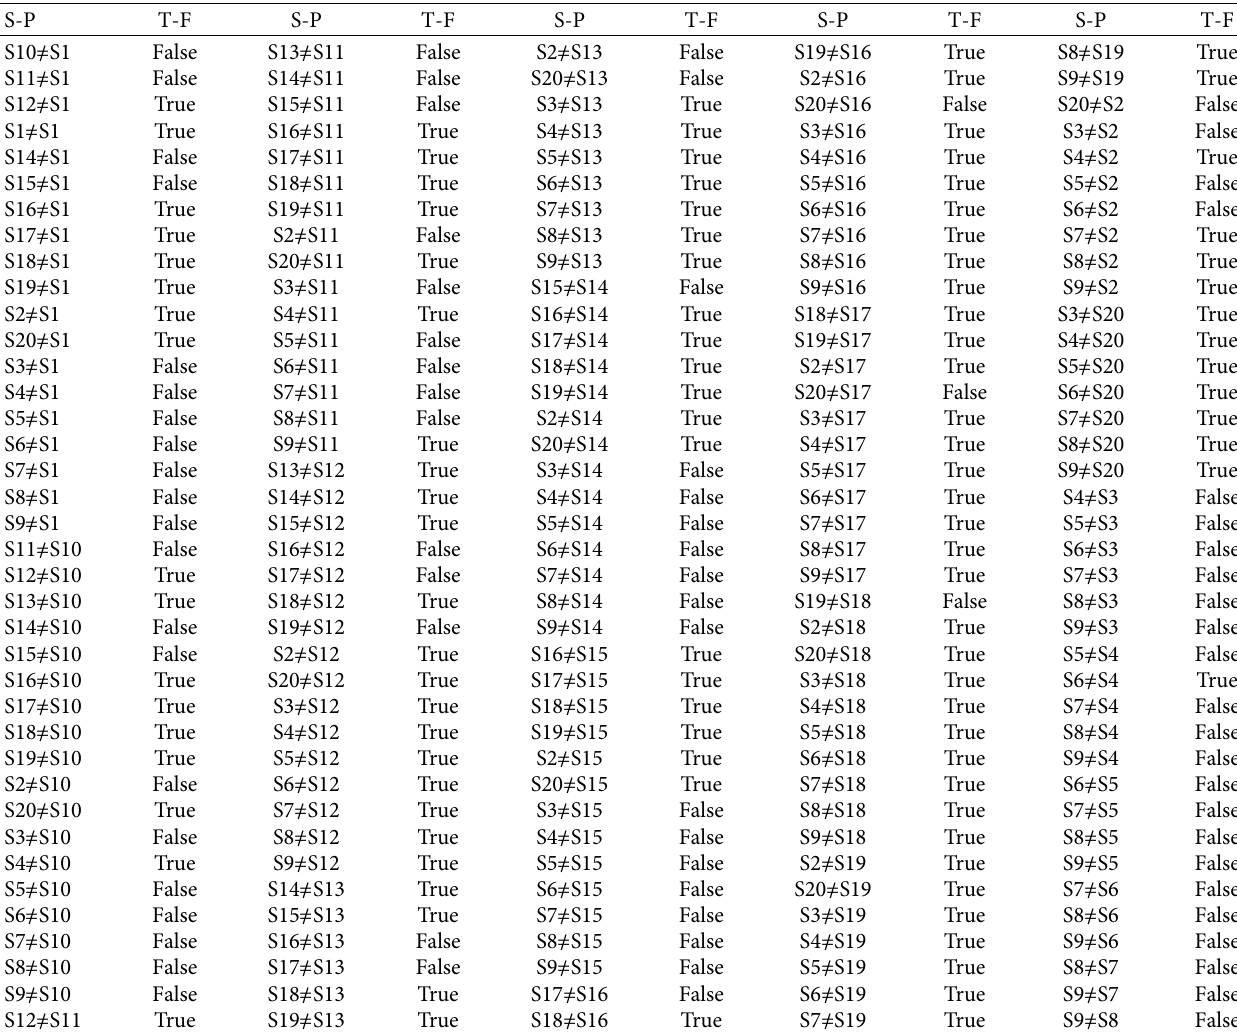
Table 5: Tukey HSD results (True-False) @ 95%CL.